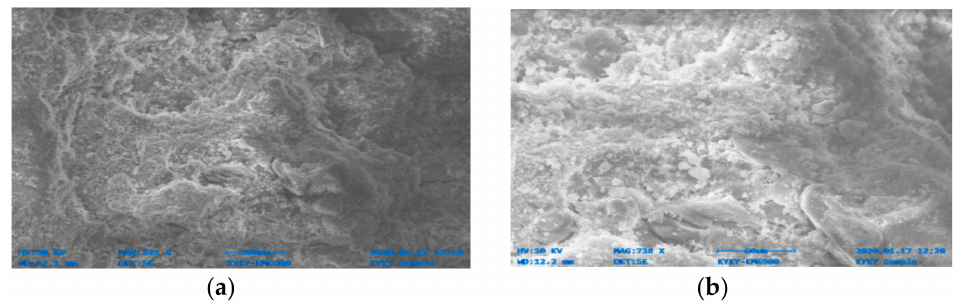
Figure 17. SEM image of GPC-D0F mix specimen; ( a ) magnification 321 × ; ( b ) magnification 738 × .